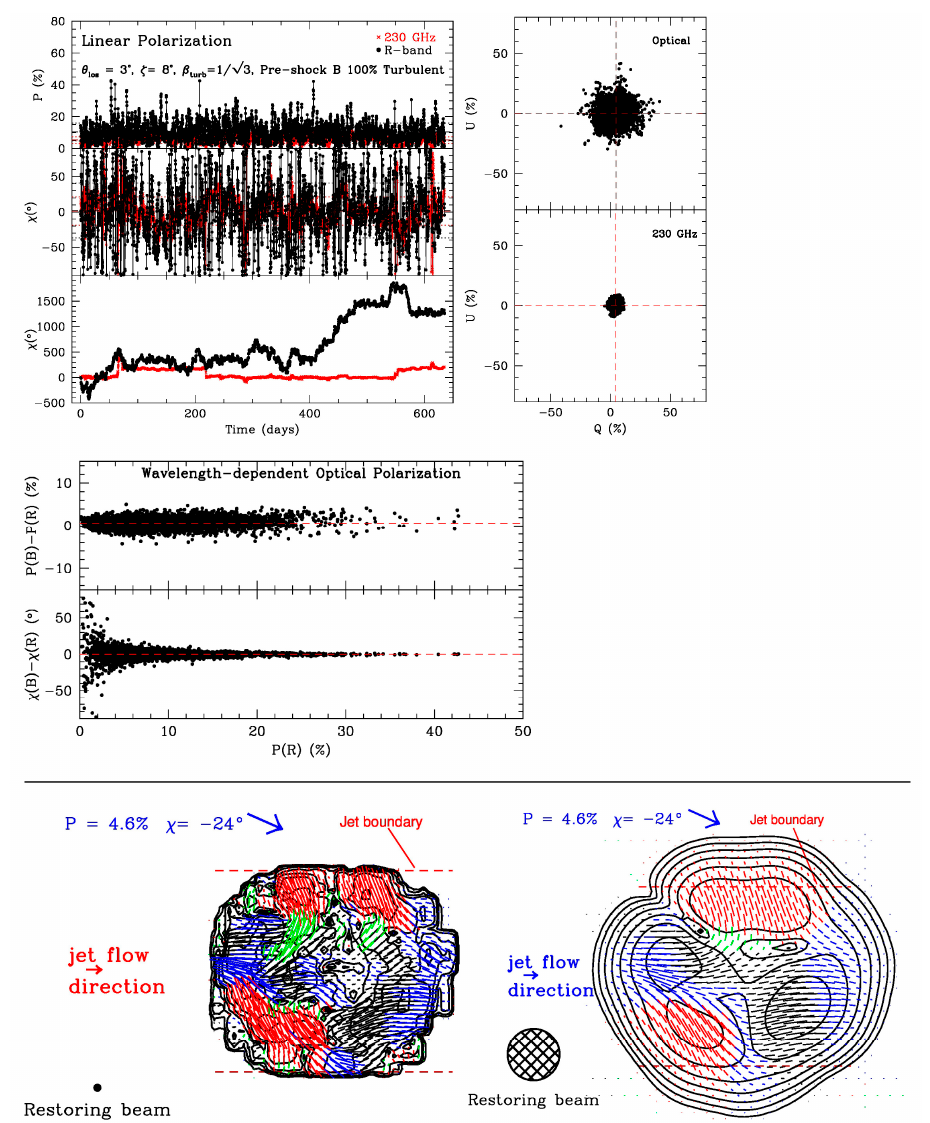
Figure 3. Same as in Figure 2, but for the case of a conical standing shock (inclined at angle ζ = 8 ° to the jet axis) through which plasma with 100% turbulent magnetic field passes.